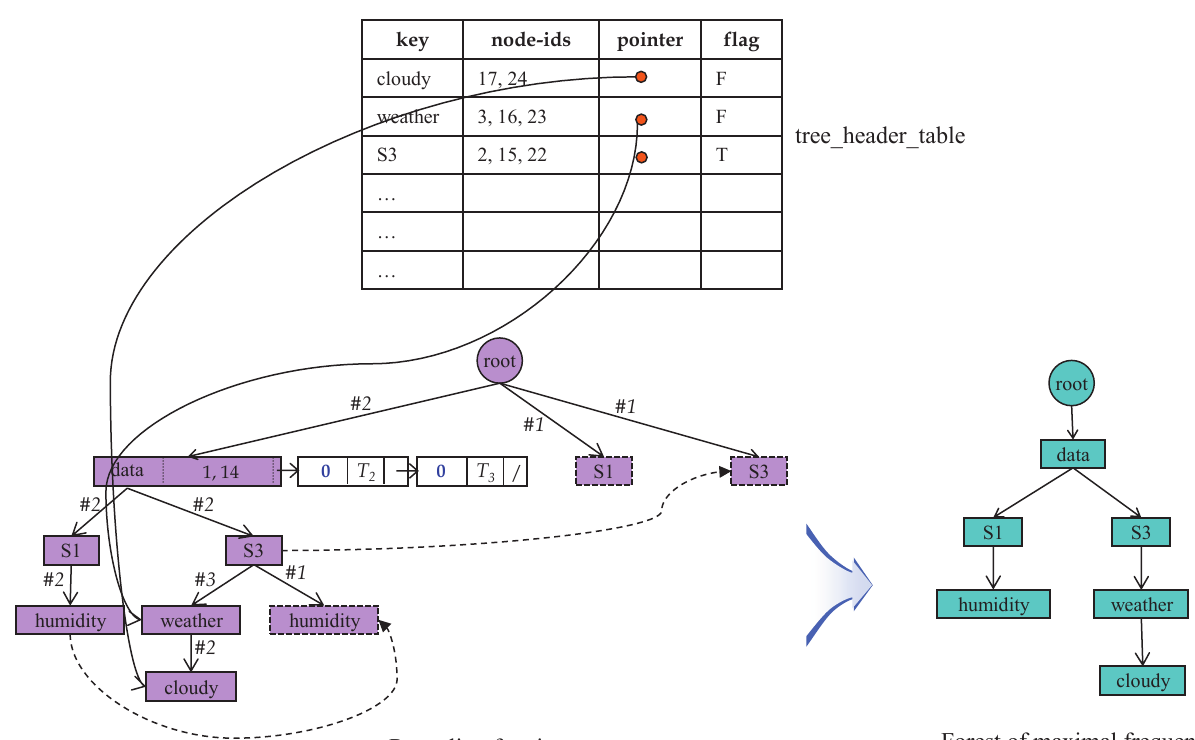
Figure 7. An example of the label extension